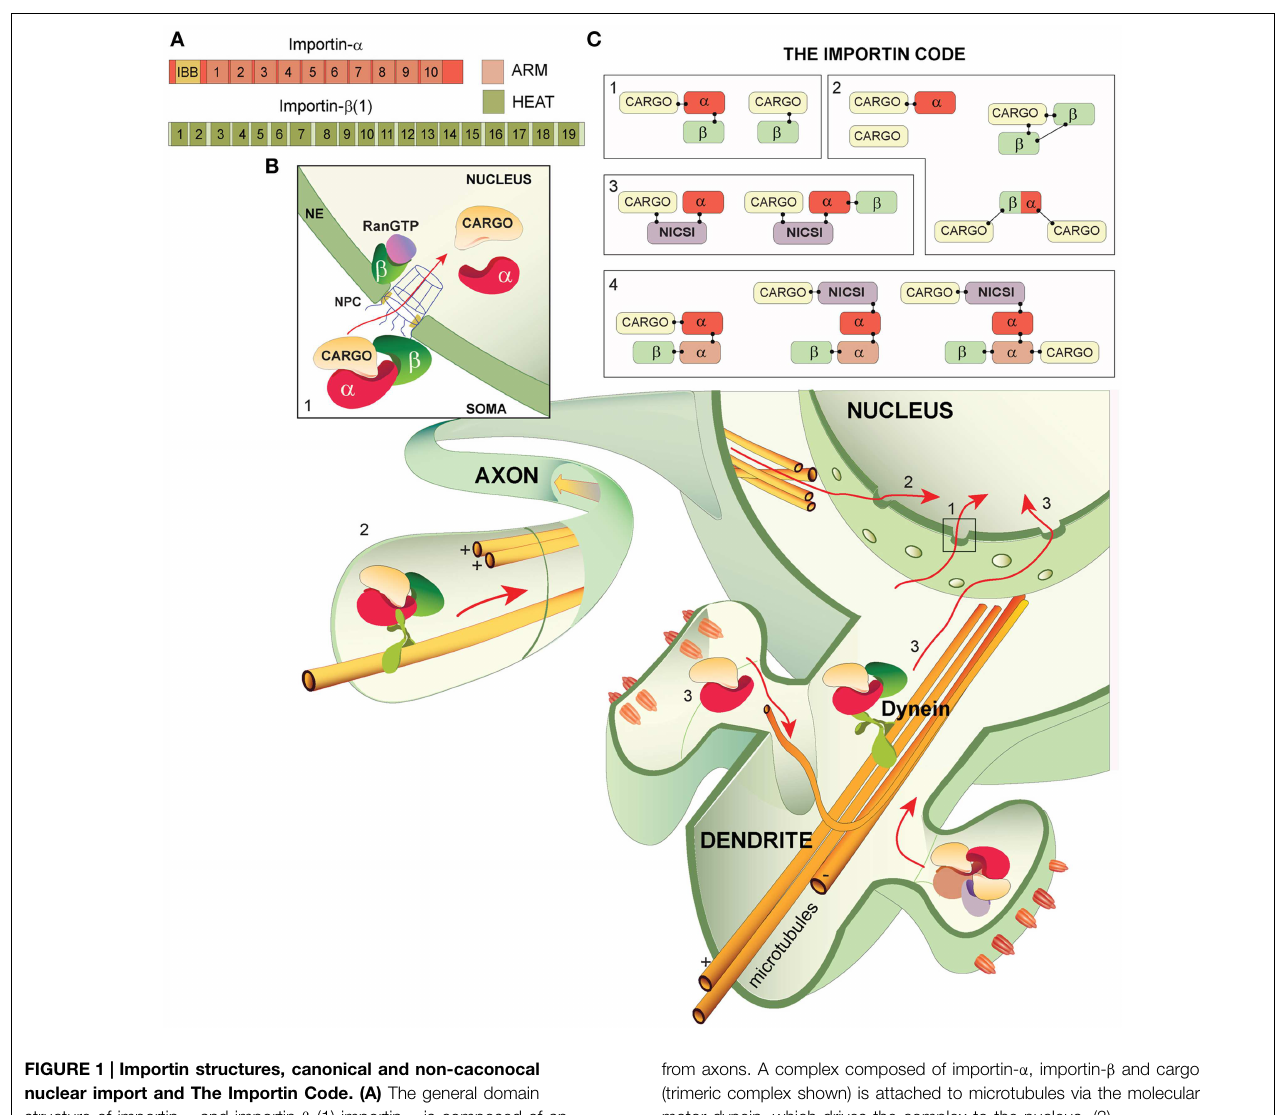
FIGURE 1 | Importin structures, canonical and non-caconocal nuclear import and The Importin Code. (A) The general domain structure of importin- α and importin- β (1) importin- α is composed of an N-terminus importin- β binding domain (IBB) followed by 10 armadillo (ARM) repeats- cargo proteins typically bind at either ARMs 2–4 (monopartite binding at the major site) or at ARMs 2–4 and ARMs 7–8 (bipartite binding at the major and minor sites, respectively). Importin- β isoforms are comprised of 19-20 HEAT repeats. (B) Nuclear import in neurons from the soma, axons and dendrites/synapses: all of which may incorporate The Importin Code and converge in the nucleus where transcriptional alterations can be induced. (1) The classical description of nuclear import. The trimeric complex (importin- α , importin- β and cargo) translocates from the soma, across the nuclear pore complex (NPC) at the nuclear envelope (NE) and into the nucleus where Ran-GTP binds importin- β , liberating components of the complex. Importin- β likely transports back to the cytoplasm, whereas the cargo and importin- α may perform nuclear functions. (2) Nuclear import